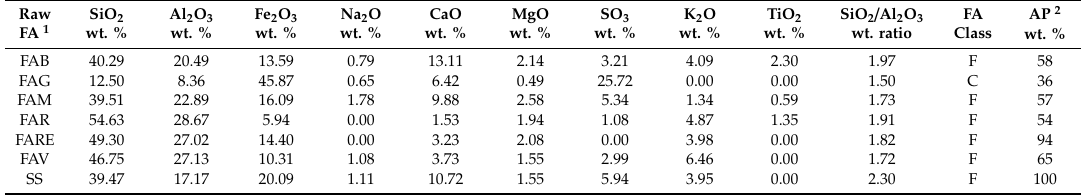
Table 1. Chemical composition and amorphous part of fly ashes (FAs) subjected to zeolitization. Raw SiO 2 FA 1 wt.